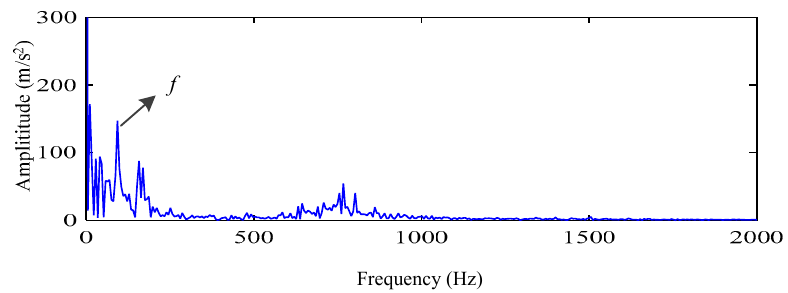
Figure 25. The envelope spectrum of the optimal component for outer ring defect by using CEEMD. Figure 26. The envelope spectrum of the optimal component for outer ring defect by using VMD.